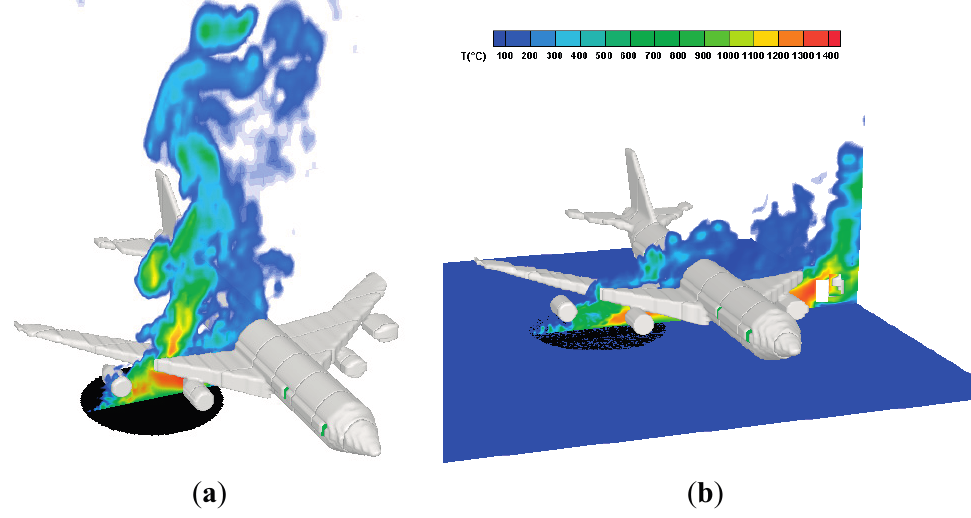
Figure 12. Instantaneous view of the predicted thermal plume. ( a ) Low wind speed of 2 m/s; ( b ) high wind speed of 10